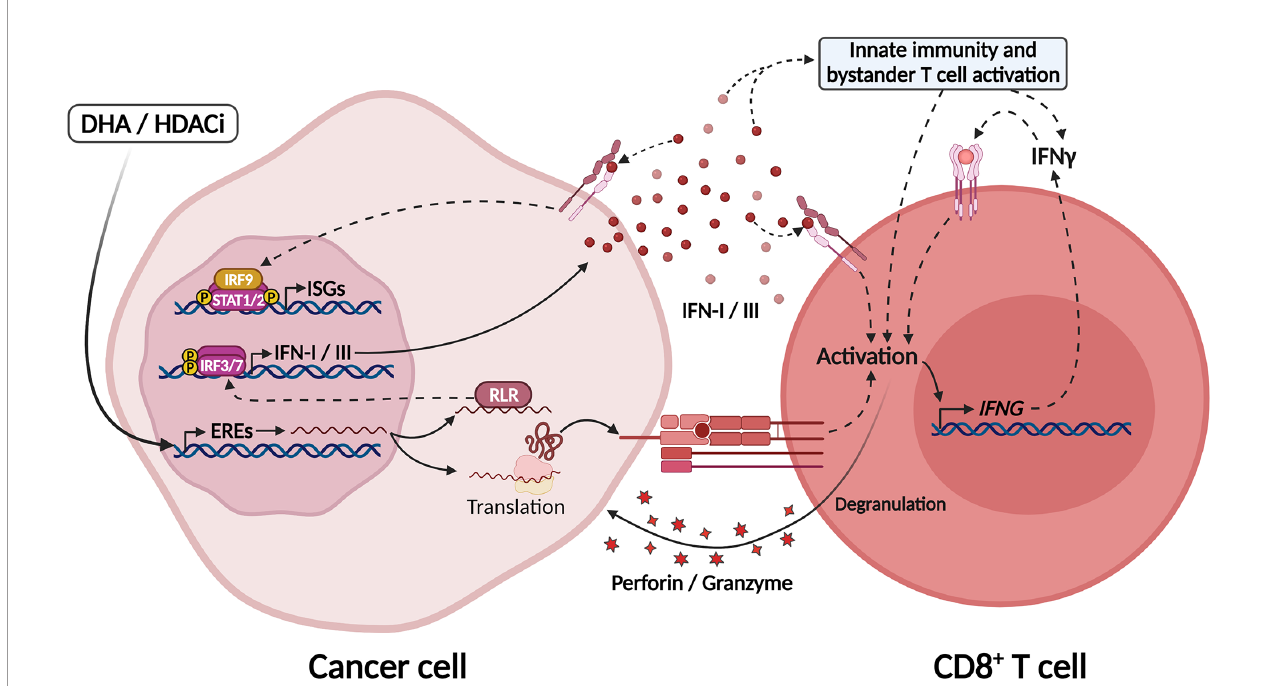
FIGURE 4 | Epigenetic modulators unleash EREs expression culminating in IFN-I/III secretion through activation of MDA5. Treatment with DNA hypomethylating agents (DHA) and histone deacetylase inhibitors (HDACi) lead to chromatin modi fi cations and unleashing of endogenous retroviral elements (EREs) in tumor cells. The intermediates formed by these elements during their replication sensitize RIG-like receptors in the cytosol, such as MDA-5 and RIG-I, which activate IRF7/9 and the production of IFN-I/III. ERE-derived RNAs might also be translated in tumor cells generating tumor-associated antigens that may be recognized by CD8+ T cells. In this manner, DHA and HDACi increase tumor immunogenicity and might be explored as adjuvants for ICB therapies. Created with